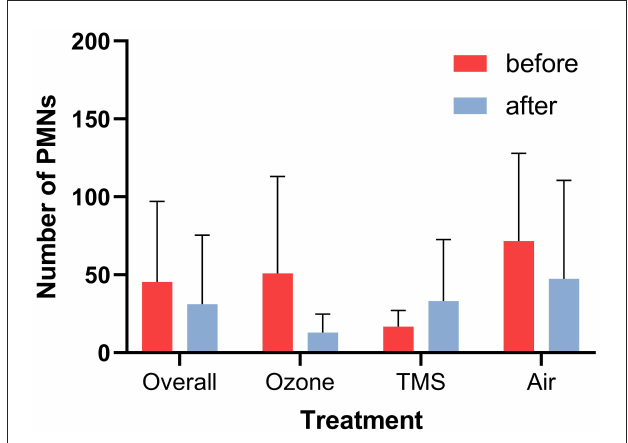
FIGURE4 Number of polymorphnuclear leukocytes (PMNs) per 10 high power fields before and after treatment as determined via endometrial cytology (mean + SD). No statistically differences were determined ( p >